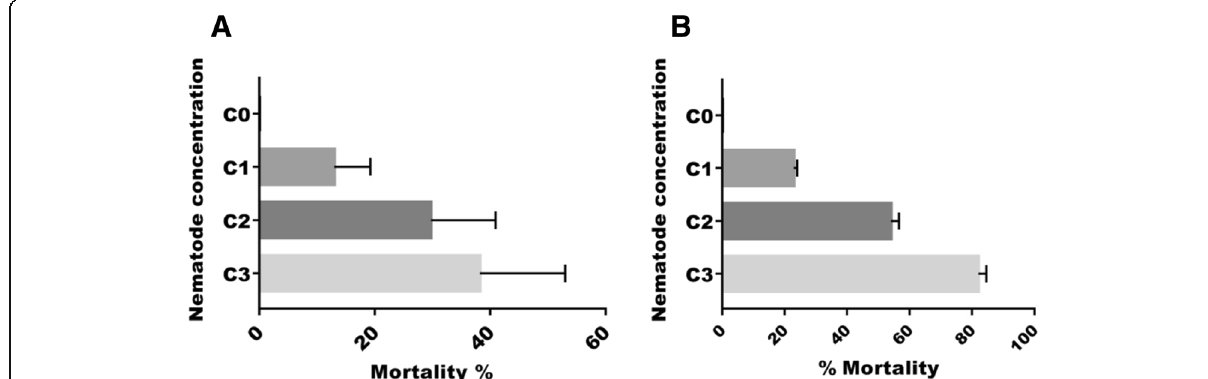
Fig. 2 M ο rtality percentage (mean ± SEM) ο f Ceratitis capitata lar ν ae treated with different c ο ncentrati ο n ο f Steinernema feltiae . a S ο il applicati ο n.